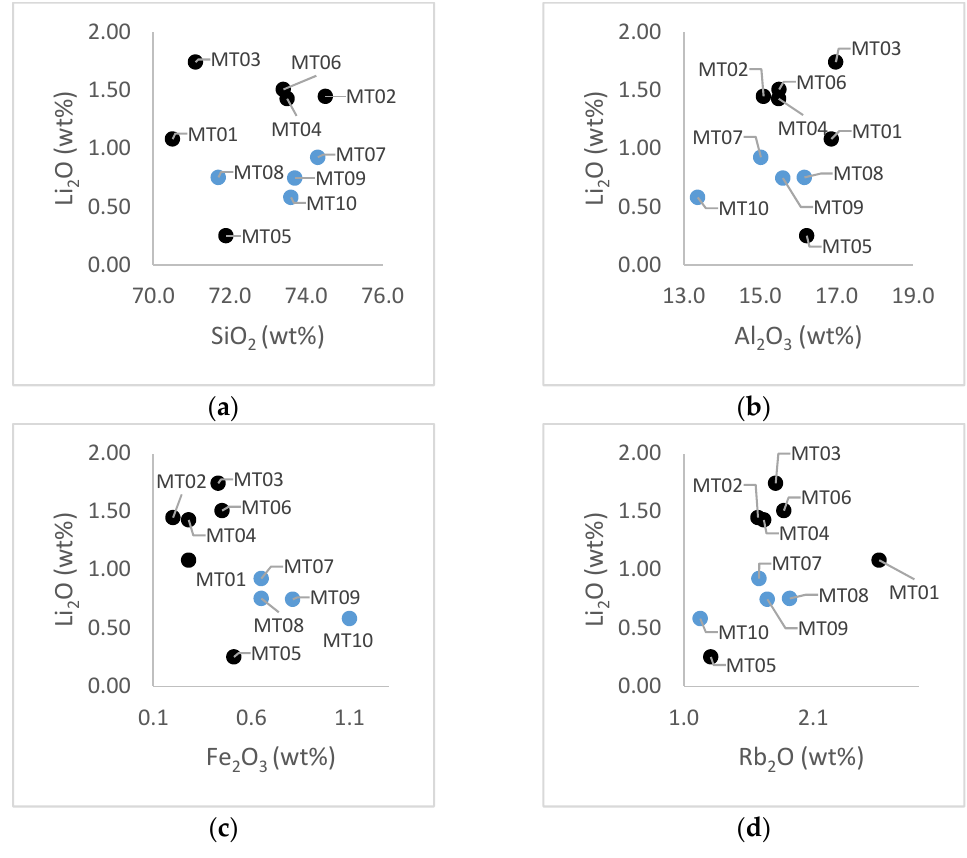
Figure 4. Chemical correlation between Li 2 O and SiO 2 ( a ), Al 2 O 3 ( b ), Fe 2 O 3 ( c ), and RbO ( d ). Black dots represent samples in G1 and blue dots samples in G2.